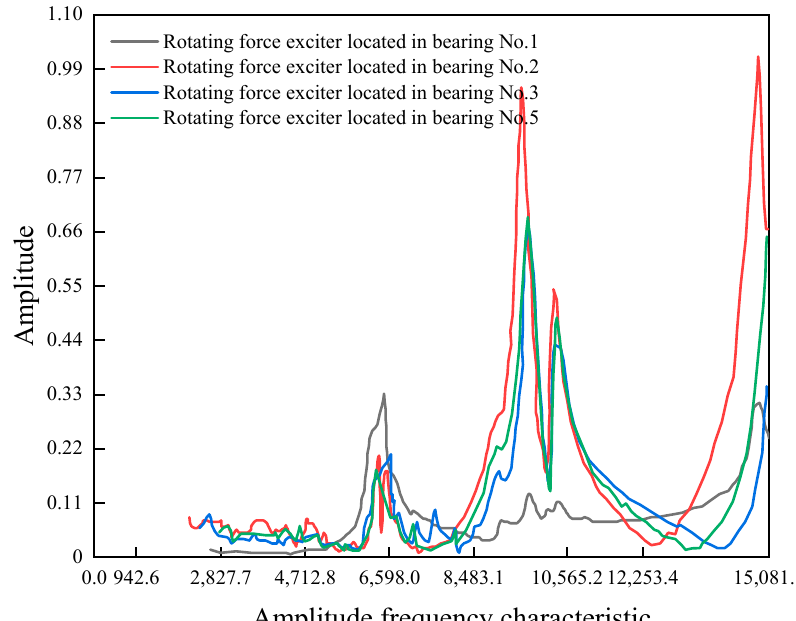
Figure 8. Vibrational transmission ratio amplitude characteristics for radial measuring point of bearing 1 with exciting force acted at different locations.